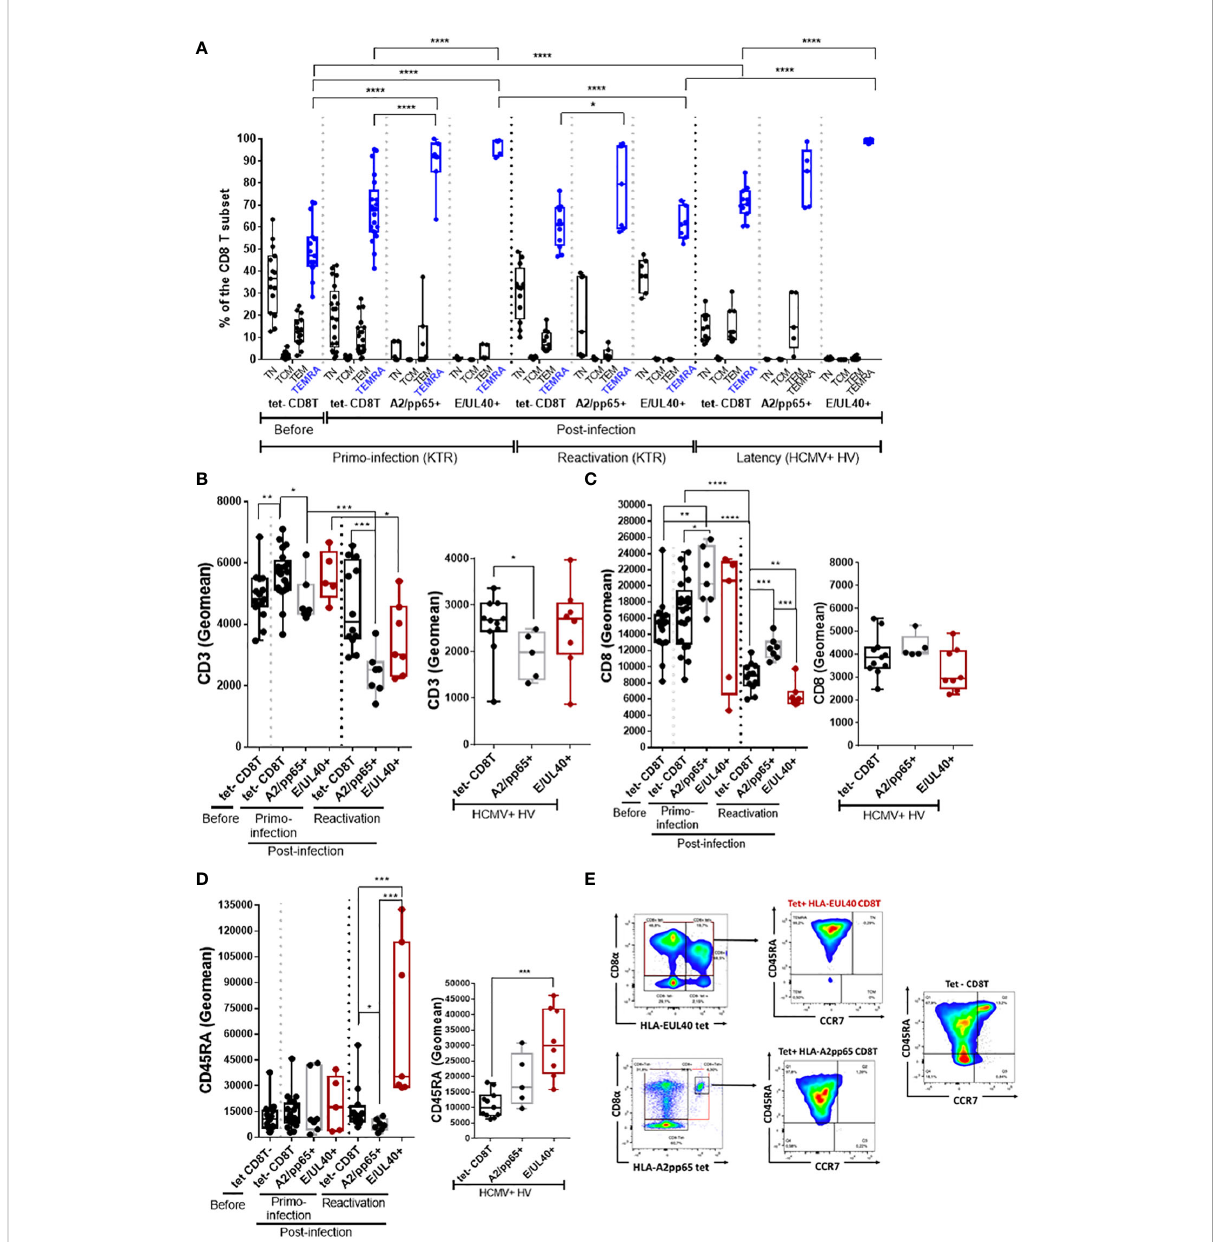
FIGURE 2 HLA-E UL40 memory CD8Tcells are TEMRA cells with distinctive levels for CD3, CD8 and CD45RA compared to HLA-A2 pp65 CD8Tcells. After immunostaining and fl uorescence acquisition CD8Tcell populations were de fi ned using a dedicated gating strategy as reported in the Materials and methods section and in Fig S3 in order to identify tetramer - CD8Tcells (tet-CD8T), HLA-E UL40 (E/UL40+) and HLA-A2 pp65 (A2/pp65+) CD8 T cells. (A – D) Box plots representations of analyses performed on HLA-E UL40 CD8T cells from KTR with a primary infection (n=5), a reactivation (n=7), from HV at latency (n=9) and on HLA-A2 pp65 CD8T cells from KTR with a primary infection (n=7), a reactivation (n=7), from HV at latency (n=10) and the respective tet- CD8T cells. Each point corresponds to a single CD8T response (A) Differentiation stage determined using CD45RA and CCR7 costaining to de fi ne naive T, central memory T cells (TCM), effector memory T cells (TEM) and terminally differentiated effector memory T cells reexpressing CD45RA (TEMRA). Data are expressed as percents of total CD8 + ab T cells in the respective subsets. Statistical analysis was performed by two-way Anova test. Comparative expression levels for CD3 (B) , CD8 (C) and CD45RA (D) in KTR before and post-infection (primary or reactivation) and HCMV + HV (latency). Data are expressed as speci fi c fl uorescence intensities (geomeans). (E) Representative fl ow histograms illustrating CD8 a and CD45RA expression at the surface of tetramer - CD8Tcells (tet-CD8T), HLA-E UL40 (E/UL40+) and HLA-A2 pp65 (A2/pp65+) CD8Tcells. (B – D) Statistical analysis was performed by Mann-Whitney U -test. p values: *for p < 0.05, **for p<0.01, ***for p<0.001 and ****for